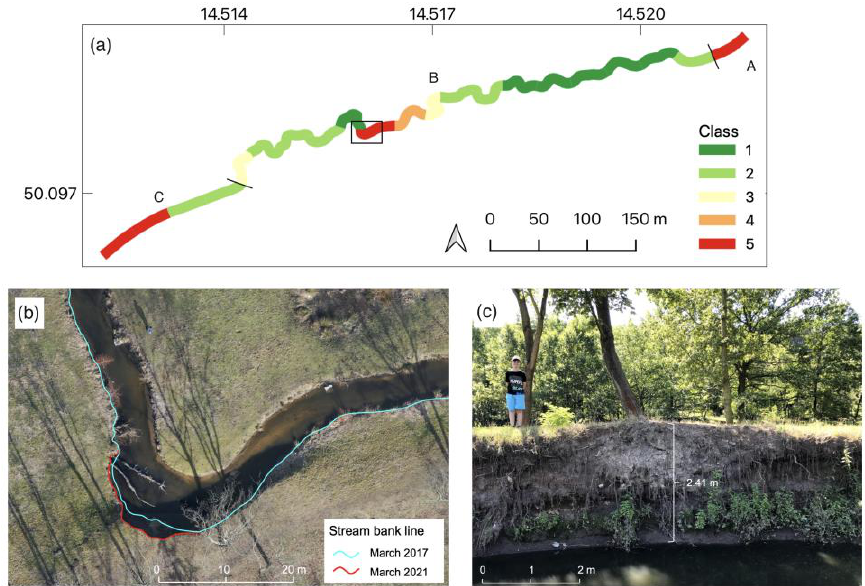
Figure 6. Assessment of channel stability at the ROK brook. ( a ) Classification of channel stability in segments. ( b ) Progress of bank erosion in a highlighted critical segment between 2017 and 2021. ( c ) Bare erosion bank of the active meander in the given segment. Imagery: J. Langhammer, 2017 – 2021.